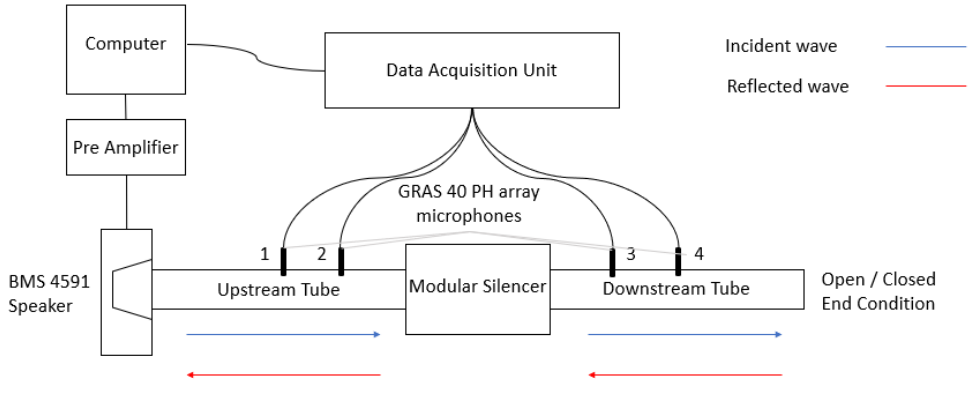
Figure 1. Two-load test rig